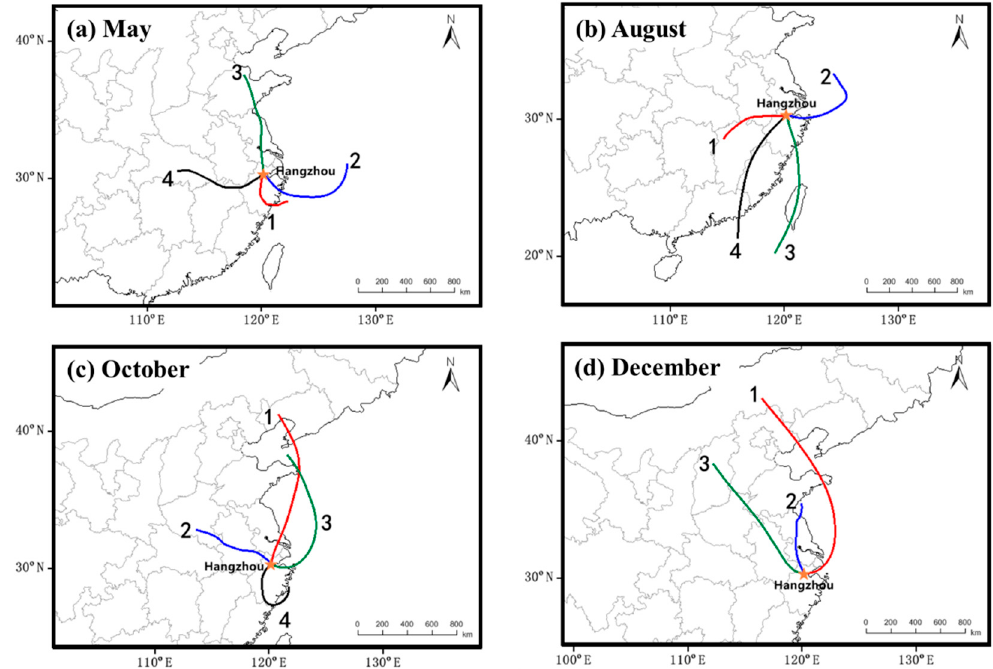
Figure 3. Clusters from 72 h backward trajectory analyses in May ( a ), August ( b ), October ( c ) and December ( d ) in 2017. Table 3. Percentages of trajectories, mean concentrations of PM 2.5 , SO 42 − , NO 3 − and NH 4+ for each trajectory cluster in May, August, October and December (see Figure 3).